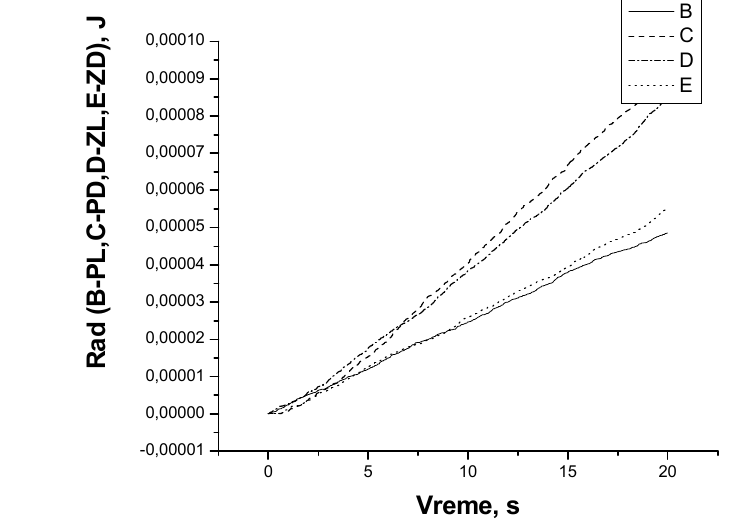
Figure 6 – Mechanical work (heat amount) in shock absorbers for a partially loaded vehicle and a speed of 5,